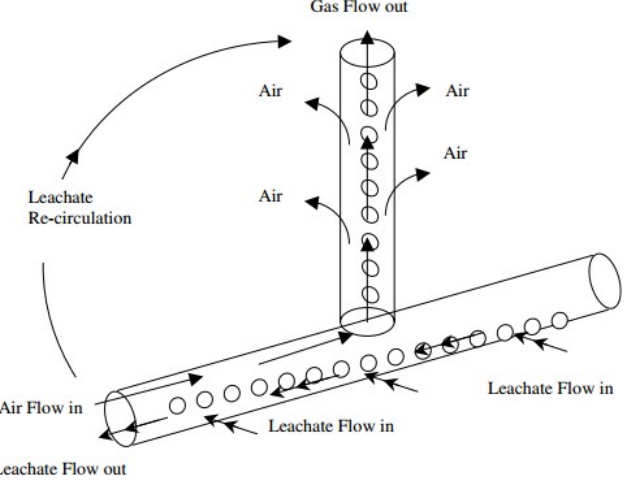
Figure 3. Leachate collection and gas ventilation pipes in a semi ‐ aerobic landfill [12].